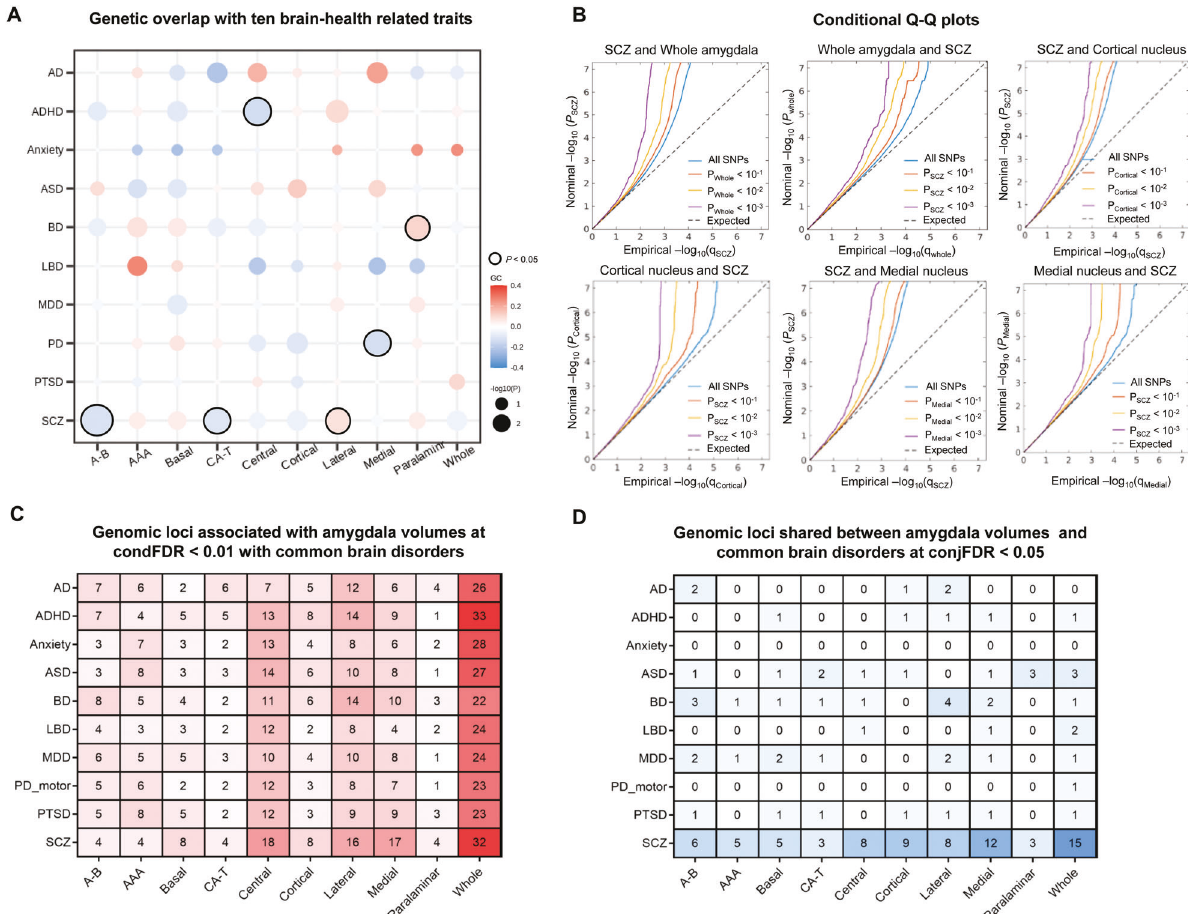
Fig. 5 Genetic overlap between amygdala volumes and ten common brain disorders. A Genetic correlations between amygdala volumes and ten brain-health-related traits were assessed using LDSC regression. Warm and cool colors indicate positive and negative associations, respectively. There were signi fi cant positive correlations between the lateral nucleus and SCZ, paralaminar nucleus and BD; negative correlations between the accessory-basal nucleus, corticoamygdaloid transition and SCZ, central nucleus and ADHD, medial nucleus and PD, as indicated by a black frame. No associations passed the FDR correcting across all 100 analyses (10 volumes × 10 traits; two-sided P FDR < 0.05). B Conditional Q-Q plots for whole amygdala volume, cortical nucleus, and medial nucleus conditioned on SCZ and vice versa, demonstrating genetic overlap. C Enhanced discovery of genetic loci for each of the amygdala volumes when condFDR analyses were run for each of the amygdala volumes conditioned on the ten brain disorders. D ConjFDR analysis detected shared genetic loci across amygdala volumes and the ten clinical conditions. LDSC linkage disequilibrium score, AB accessory-basal nucleus, AAA anterior-amygdaloid-area, CAT corticoamygdaloid transition, AD Alzheimer ’ s disease, ADHD attention-de fi cit/hyperactivity disorder, ASD autism spectrum disorders, BD bipolar disorders, LBD Lewy body dementia, MDD major depression disorders, PD Parkinson ’ s disease, PTSD Post-traumatic stress disorder, SCZ schizophrenia, Q-Q quantile-quantile, FDR false discovery rate, condFDR conditional FDR, conjFDR conjunctional